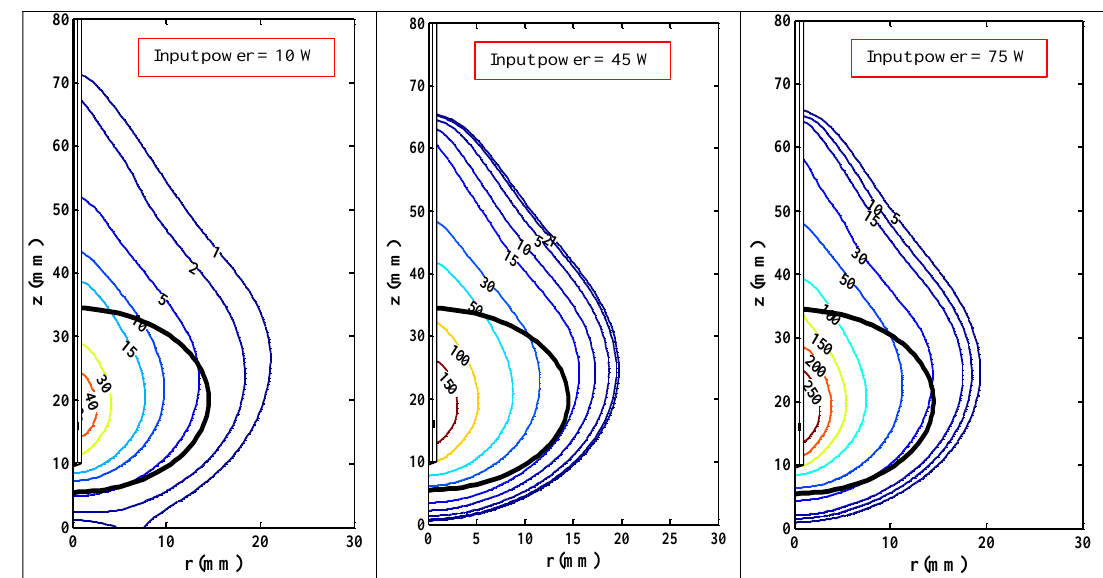
Figure 9. Spatial distribution of ( ∆𝑇 = 𝑇 − 𝑇 𝑏𝑙𝑜𝑜𝑑 ) for various input powers at t = 300 s.